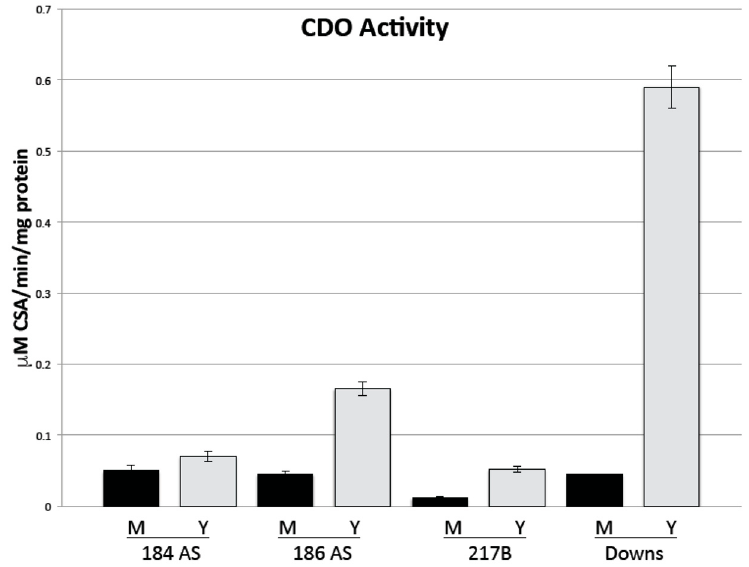
Figure 3. Cysteine dioxygenase activity. M, mold; Y, yeast. Activity was normalized to protein level within the extract. Error bars are the standard error of the mean of triplicate independent experiments.